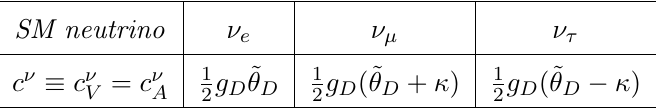
Table 4 . Neutrino couplings in a 2HDM